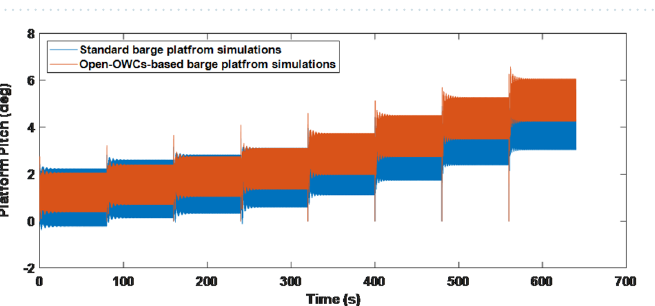
Figure 4. Interfacing modules to achieve aero-hydro-servo-elastic simulations.